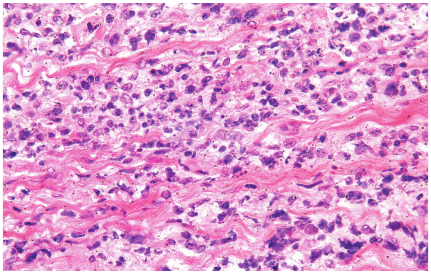
Figure 4: Mediastinal large B-cell lymphoma biopsy (high